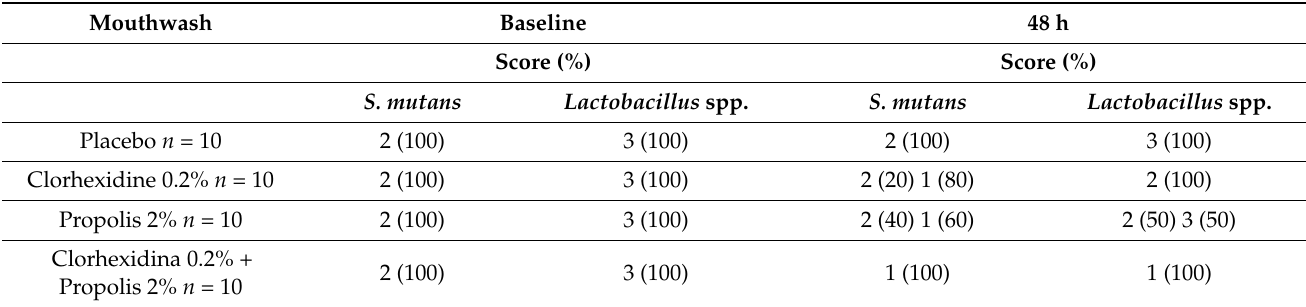
Table 2. Results of different mouthwashes’ formulation on oral antimicrobial effect.